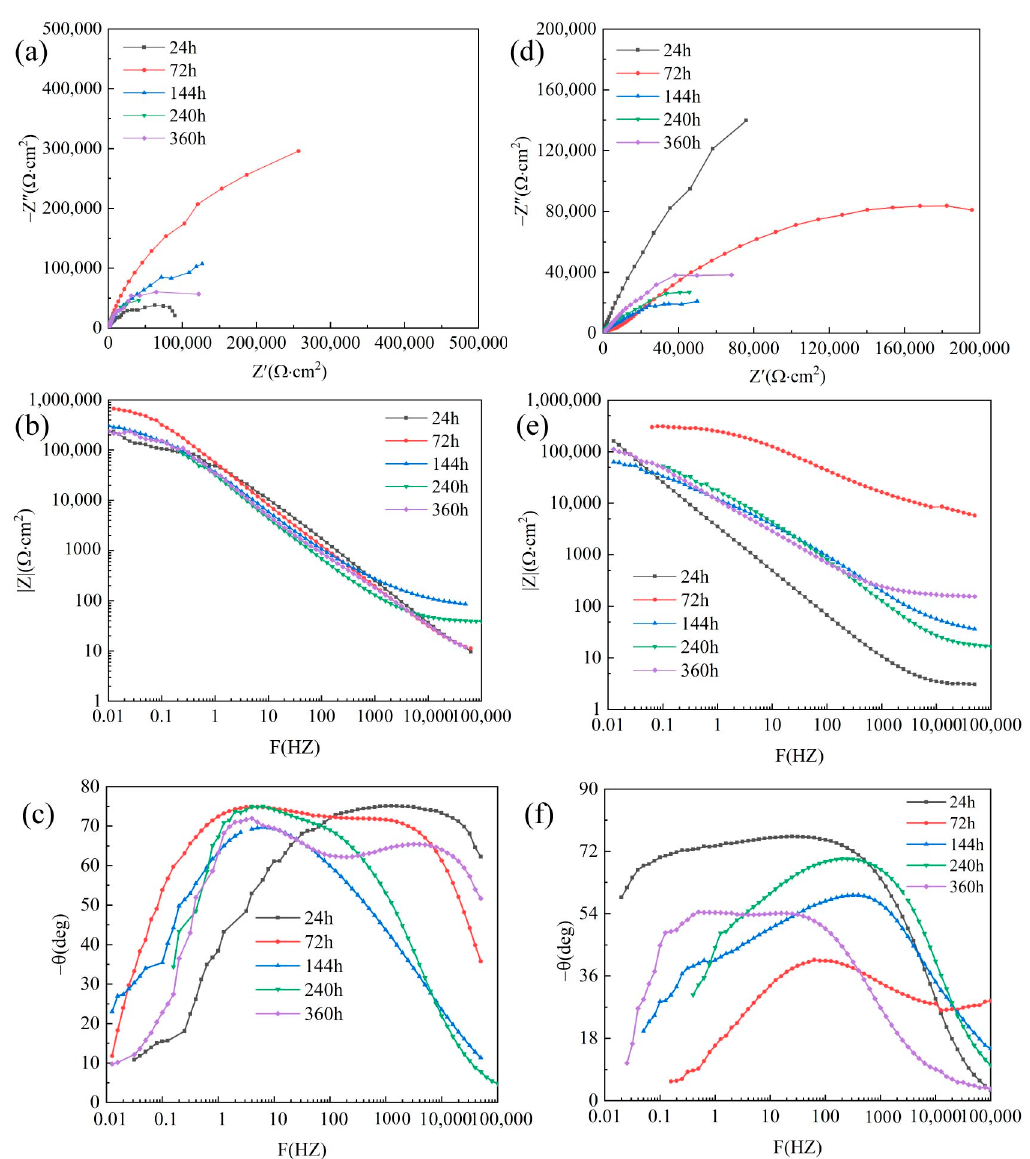
Figure 10. EIS of Al 2 O 3 3D/5083 Al( d – f ) and EIS of 5083Al alloy ( a – c ) after NSS at different times: ( a , d ) Nyquist diagram; ( b , e ) Bode diagram (|Z|-F); ( c , f ) Bode diagram ( −θ -F).